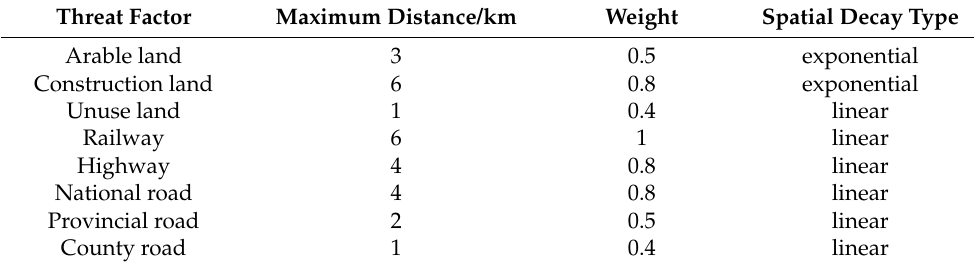
Table 1. Weights and maximum impact distances of threat factors.